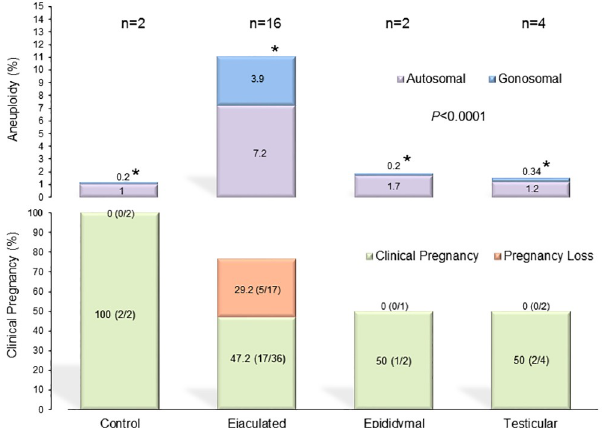
Fig 2. Sperm aneuploidy assessed by NGS in specimens of different origins with related pregnancy outcome. The two-sample t -test and Mann-Whitney U test were used to compare the autosomal and gonosomal aneuploidy rates assessed by NGS in at least 1000 spermatozoa and evidenced that the ejaculated (n = 16) specimen had a higher incidence of aneuploidy than the epididymal (n = 2), testicular (n = 4), and donor control specimen (n = 2) ( P < 0.0001) (Upper graph). In the lower graph, the clinical pregnancies and their evolution into miscarriage or term, assessed by Friedman’s Chi-square test, are represented according to the source of spermatozoa used for ICSI. No statistical difference was found in this analysis.